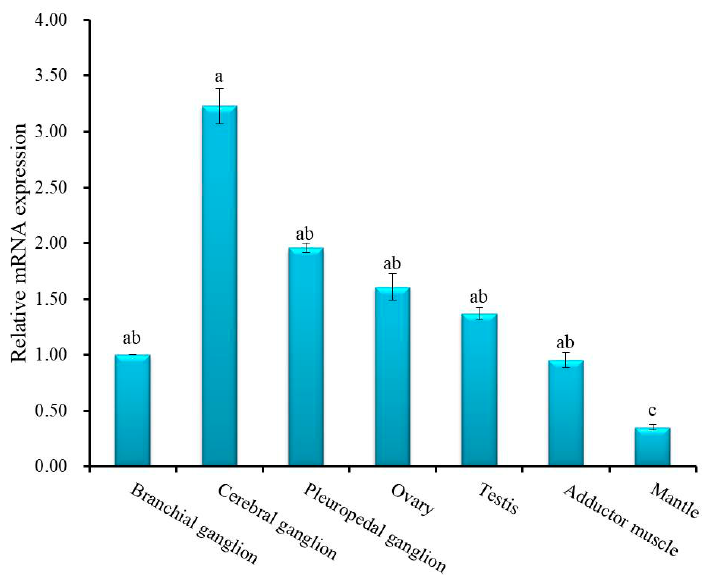
Figure 5. Relative mRNA expression level of Hdh IGFBP-5 (means ± SD, N = 3) in various tissues of H. discus hannai . Data were compared with relative values in branchial ganglion (1). Different letters indicate significant differences from each other ( p < 0.05). Significantly higher expression of cerebral ganglion is indicated by a. The expression among branchial ganglion, pleuropedal ganglion, ovary, testis, and adductor muscle are not differ significantly, indicated by ab. Significantly lower expression was found in the mantle tissue, which is indicated by c.